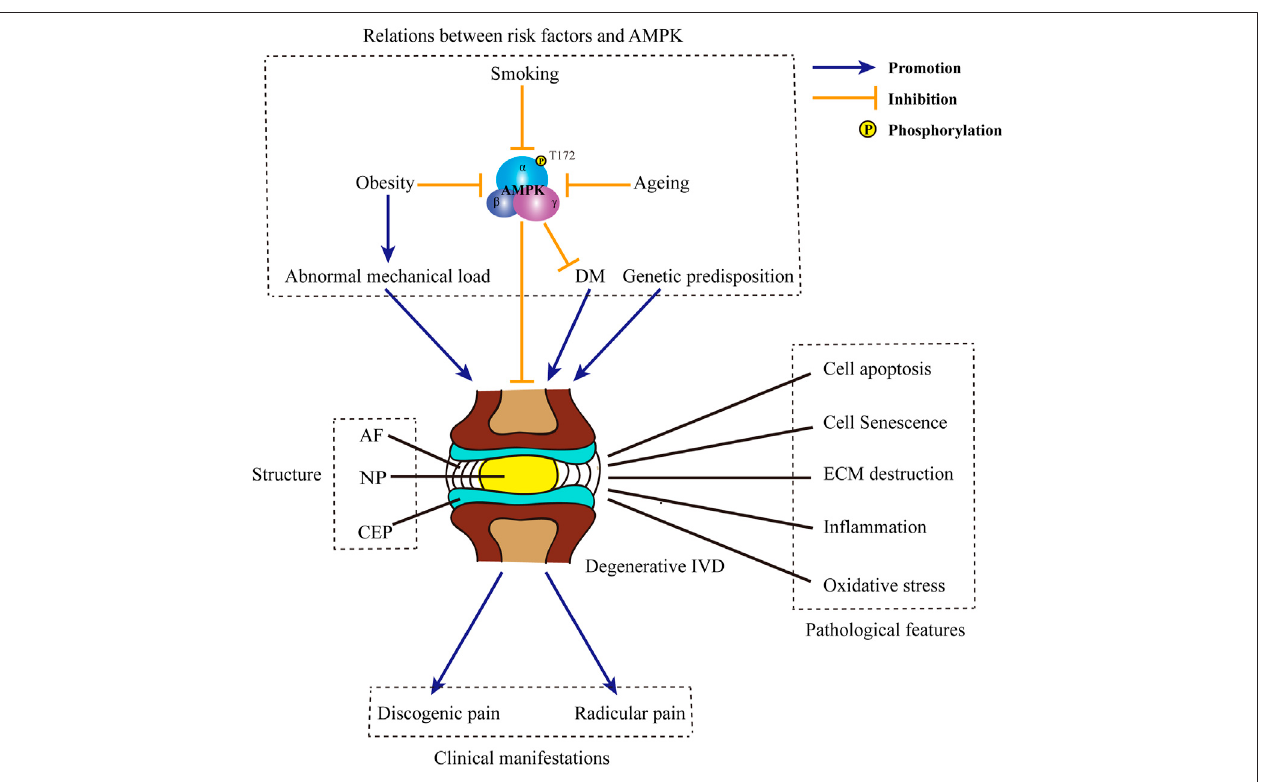
FIGURE 1 | Structure of IVD and the pathogenesis of IDD. IVD is composed of three main parts: the core NP, the peripheral AF and CEP located in the top and bottom. CausativefactorsforIDDincludeobesity,ageing,smoking,DM,abnormal mechanicalload,geneticpredisposition,etc.Someofthosefactors, suchasobesity, ageing and smoking may negatively regulate the phosphorylation of AMPK and inhibit AMPK activity. Besides, inactivation of AMPK may induce the occurrence of DM. Typicalpathologicalfeatures indegenerativeIVDincludescellapoptosis andsenescence,ECMdestruction,in fl ammation,oxidativestress,etc. Theprogressionof IDD may ultimately bring about discogenic pain and radicular pain. IVD: intervertebral disc; IDD: intervertebral disc degeneration; NP: nucleus pulposus; AF: annulus fi brosus; CEP: cartilage endplates; DM: diabetes mellitus; AMPK: AMP-activated protein kinase; ECM: extracellular matrix.